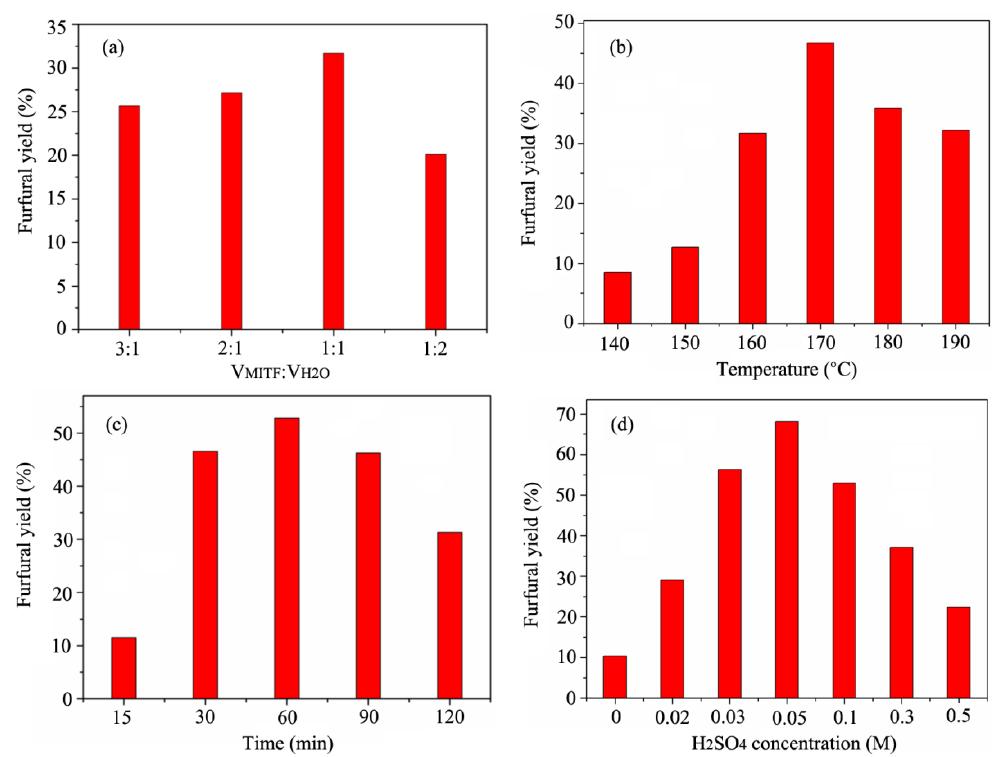
Figure 1. Furfural yields by the 2-Methyltetrahydrofuran/aqueous (MTHF/H 2 O) system under different conditions: ( a ) volume ratios of MTHF/H 2 O; ( b ) reaction temperatures; ( c ) reaction